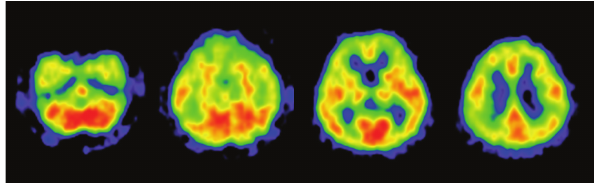
Figure 6: [ 15 O]H 2 O positron emission tomography (PET) of Case B. It showed decreased perfusion in the bilateral parietal area and inferior temporal area. Mild decreased perfusion is also observed in the posterior cingulate cortex. These findings suggested comorbid Alzheimer’s